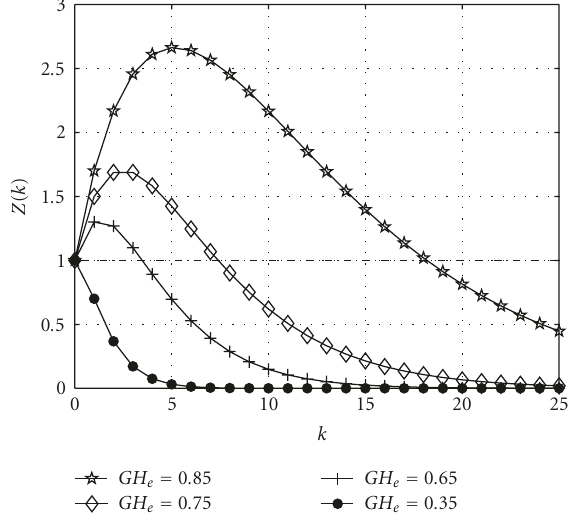
Figure 2: Relative sensitivity function Z ( k